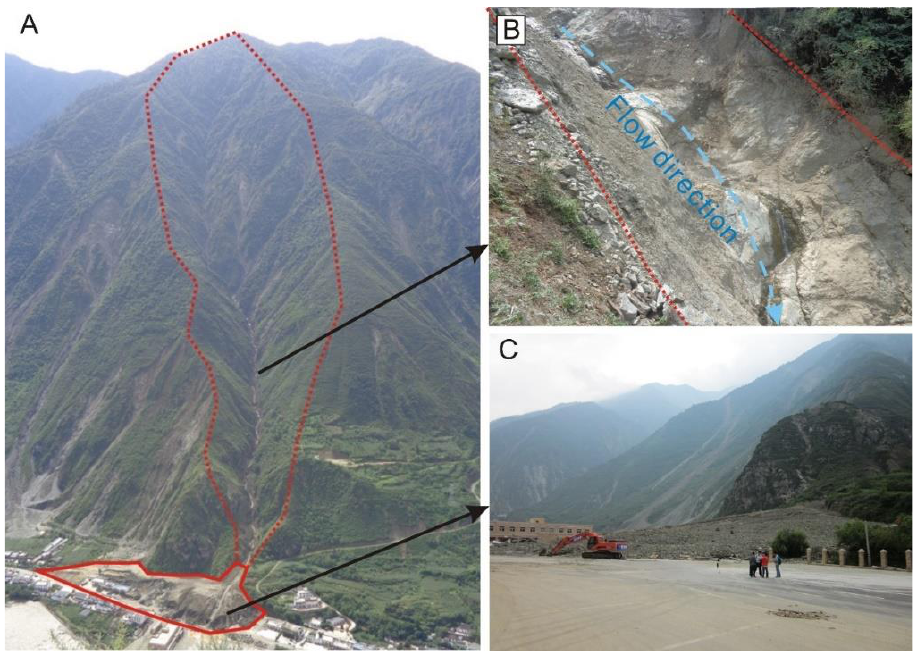
Figure 2. ( A ) Panoramic view of Wayao debris flow taken on 7 August 2013. The dashed red line indicates the catchment boundary, and the solid red line indicates the extent of the debris fan. ( B ) The debris deposition along the channel was eroded by the debris flow in 2013. The blue line indicates the debris flow direction, and the red lines indicate the trace of the debris flow. ( C ) The debris fan of the Wayao debris flow in 2013.